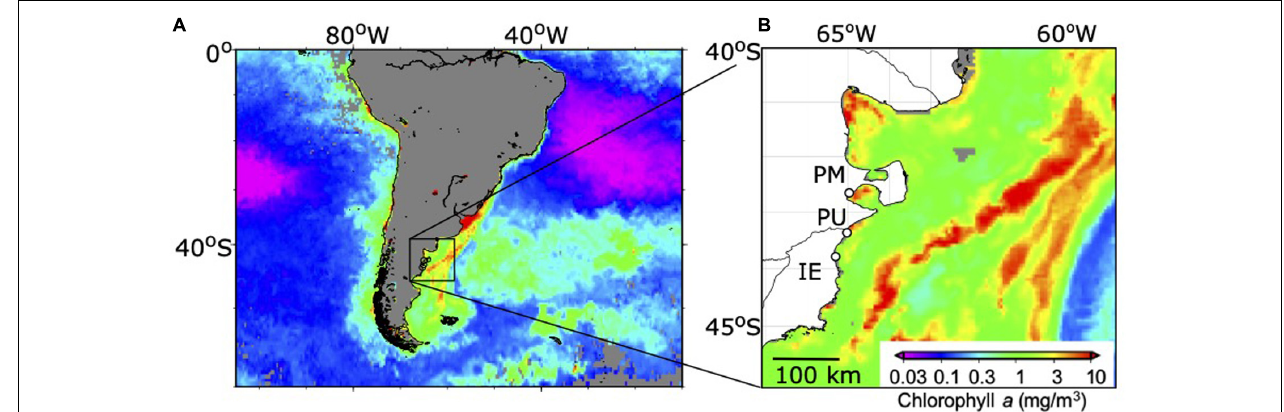
FIGURE 1 | Sampling sites on the South West Atlantic coast. Background contours denote satellite-derived (MODIS-Aqua) chlorophyll a concentration, composited over (A) 1 month average (1–31 October, 2017) and (B) 8 days average (8–15 October, 2017). Daily Moderate Resolution Imaging Spectroradiometer-Aqua (MODIS) level-3 Chl a (in mg m − 3 ) with 4-km resolution were obtained from NASA Goddard Space Flight Center (https://oceancolor.gsfc.nasa.gov/). Open circles represent sampling sites: PM, Puerto Madryn; PU, Playa Unión; IE, Isla Escondida (Chubut Province, Argentina).